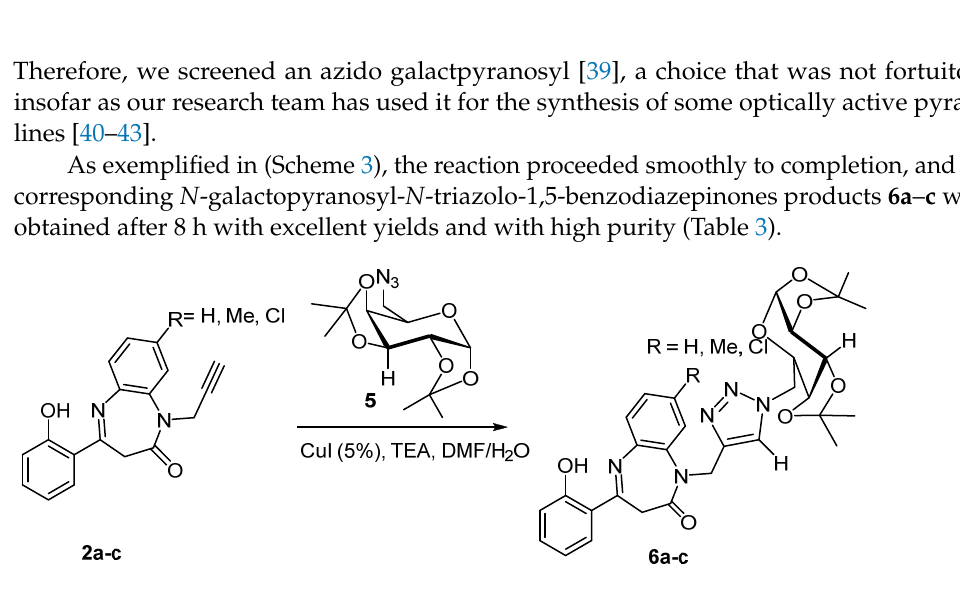
Table 3. One-pot synthesis of 1,4-disubstituted 1,2,3-triazoles 6a – c .